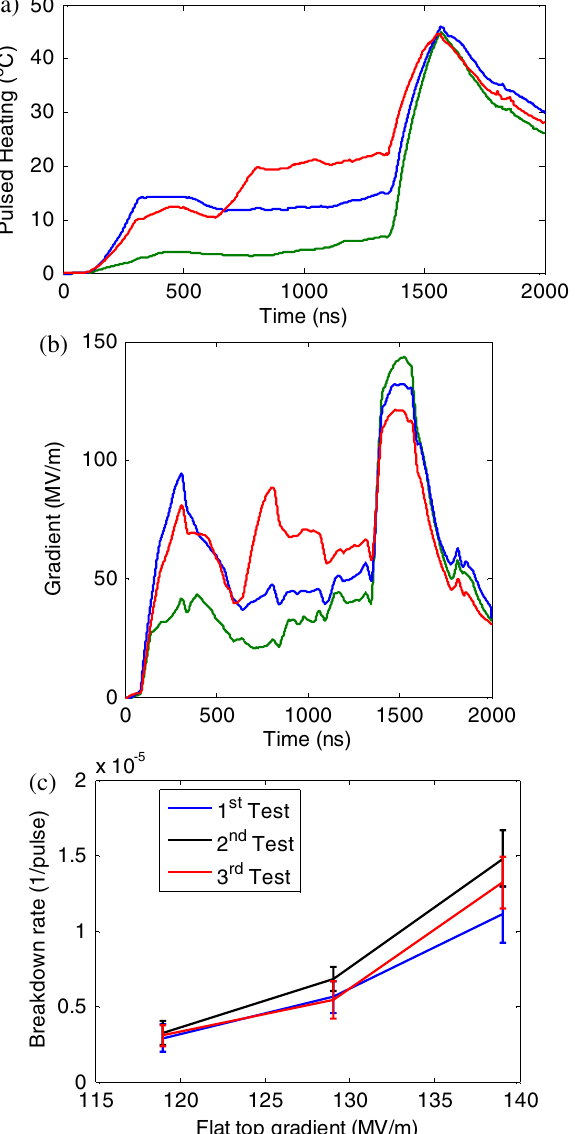
FIG. 6. (a) Peak surface temperature rise and (b) acceleration gradient profiles for X -band single cell SW cavity test runs with similar peak pulsed heating but different main pulse gradients. (c) Test 105 times what it is at 119 MV = m . The test results plotted in Fig. 6(c), however, only show a quadrupling of break- down rate over this gradient range. According to these experiments, the breakdown rate varies depending on the pulsed heating temperature rise.